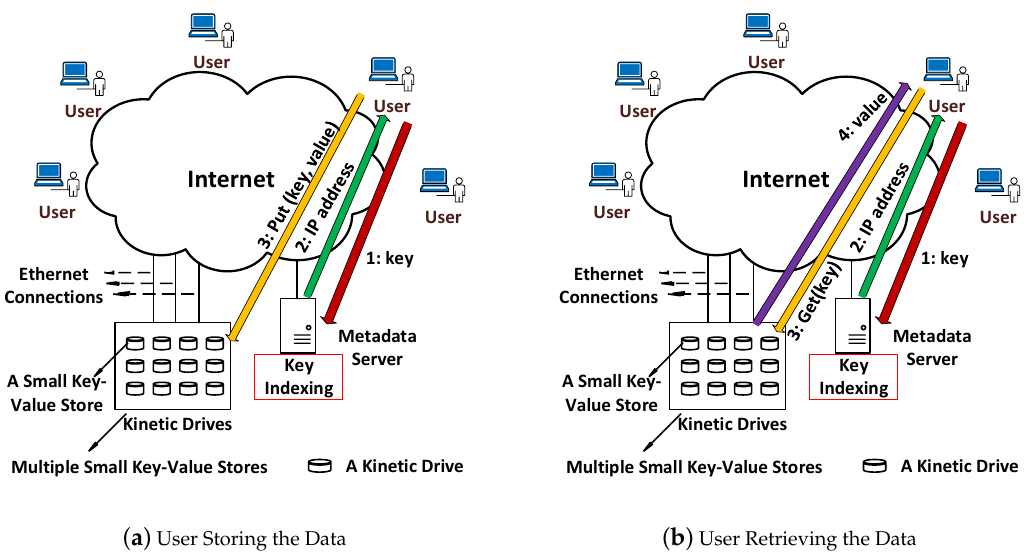
Figure 4. Data access with a cluster of Kinetic Drives